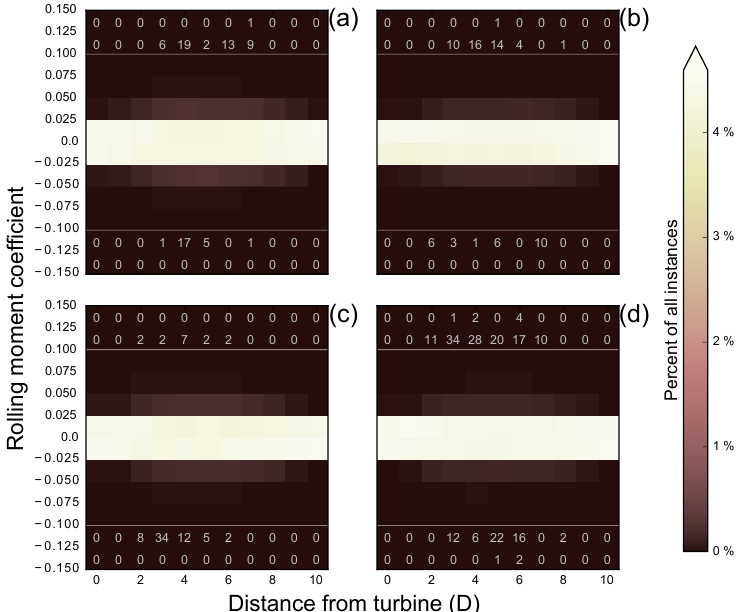
Figure 5. Two-dimensional histograms of all calculations of rolling moment coefficient experienced by all aircraft in the neutral (a, b) and stable (c, d) cases for down-wake (a, c) and cross-wake (b, d) transects as a function of the downwind distance from the turbine (in rotor diameters D ). “Non-low” hazards ( | C roll | > 0 . 1) are explicitly totalled in their respective